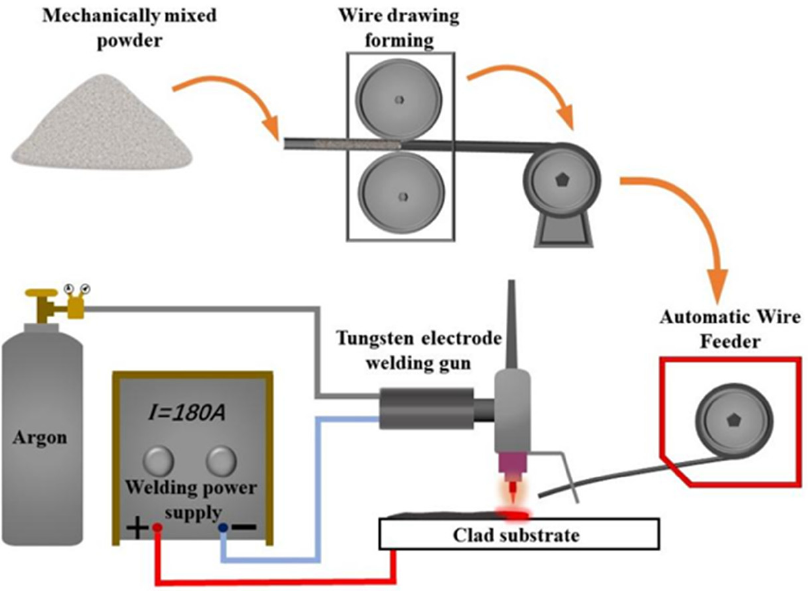
Figure 1. Schematic diagram of the process of the FeCrMnCuNiSi 1 high-entropy alloy coating. The specimens with sizes of 10 mm × 10 mm and 20 mm × 20 mm were cut from